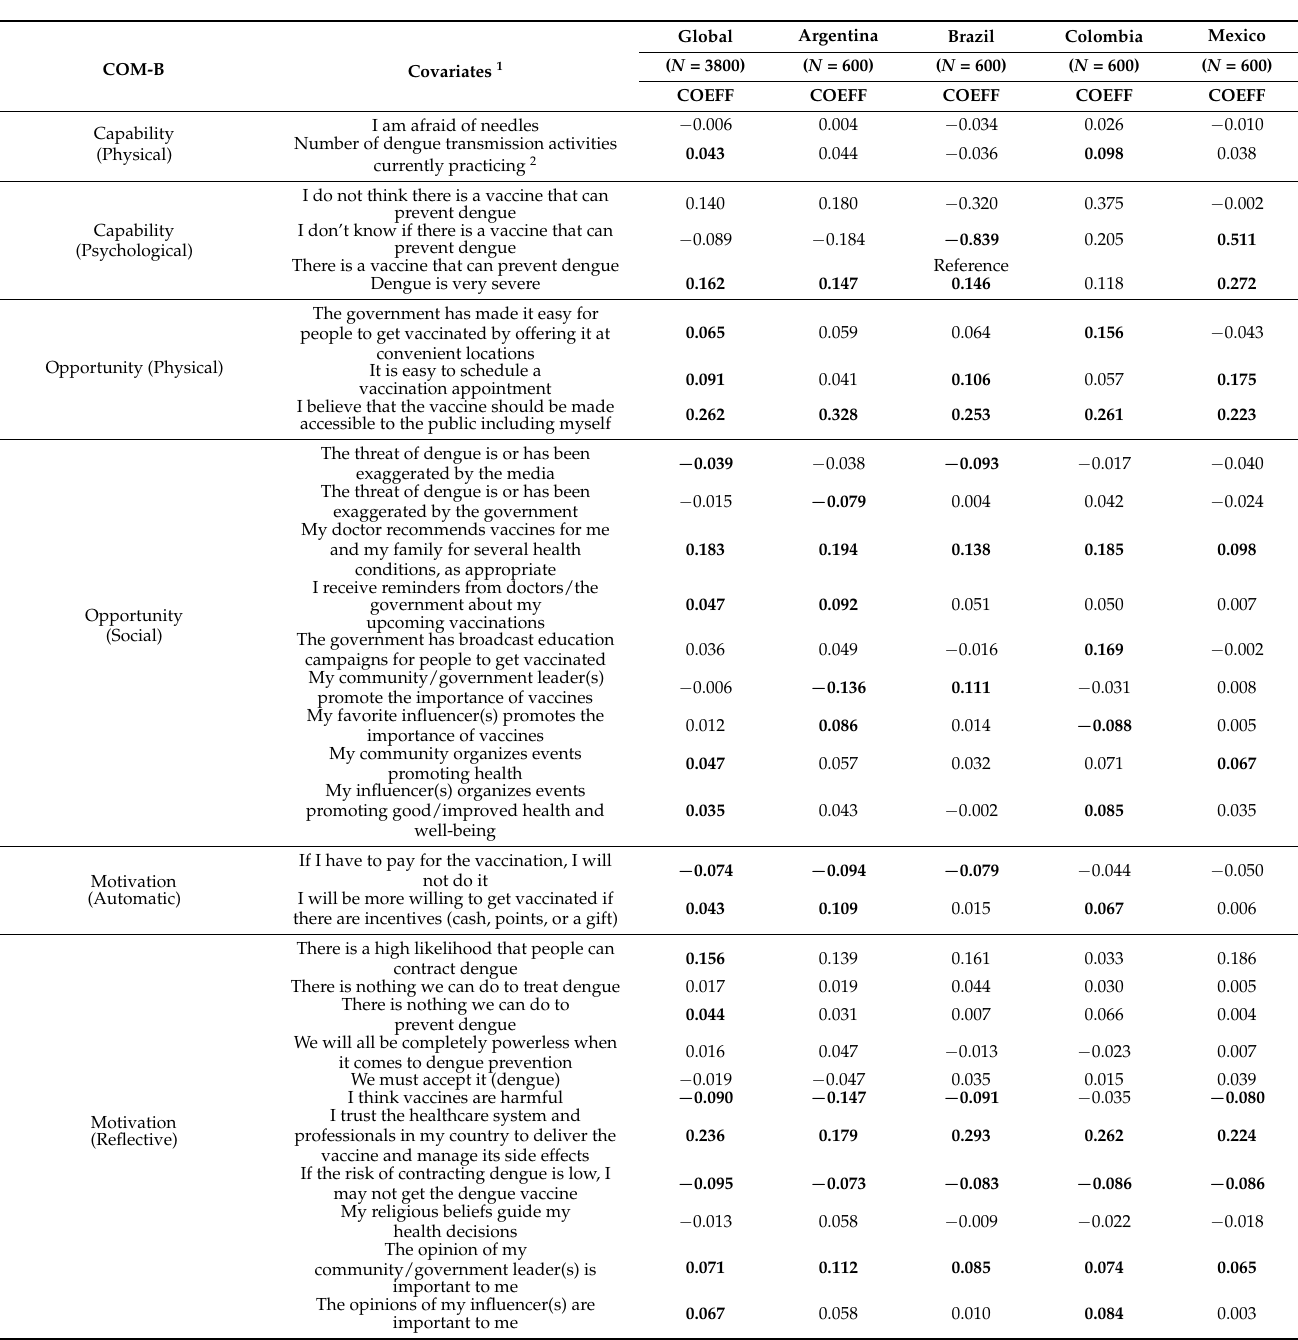
Table 3. Capability, Opportunity, Motivation factors associated with willingness to vaccinate against dengue globally and by country in Latin